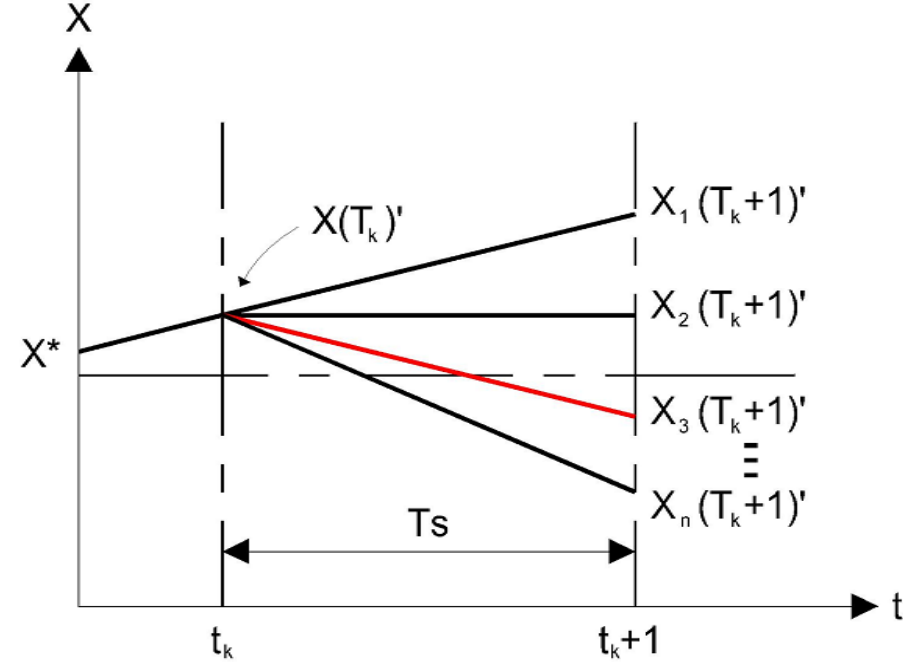
Figure 3. Voltage vector evaluation and selection for DPM.